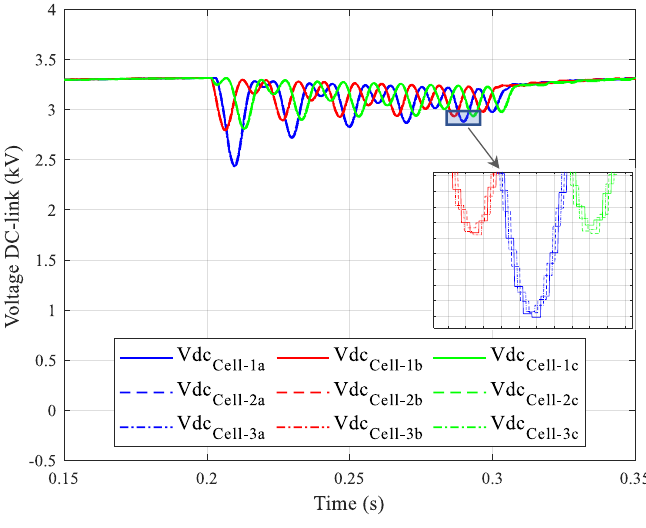
Figure 14. Bridge dc capacitor voltages.